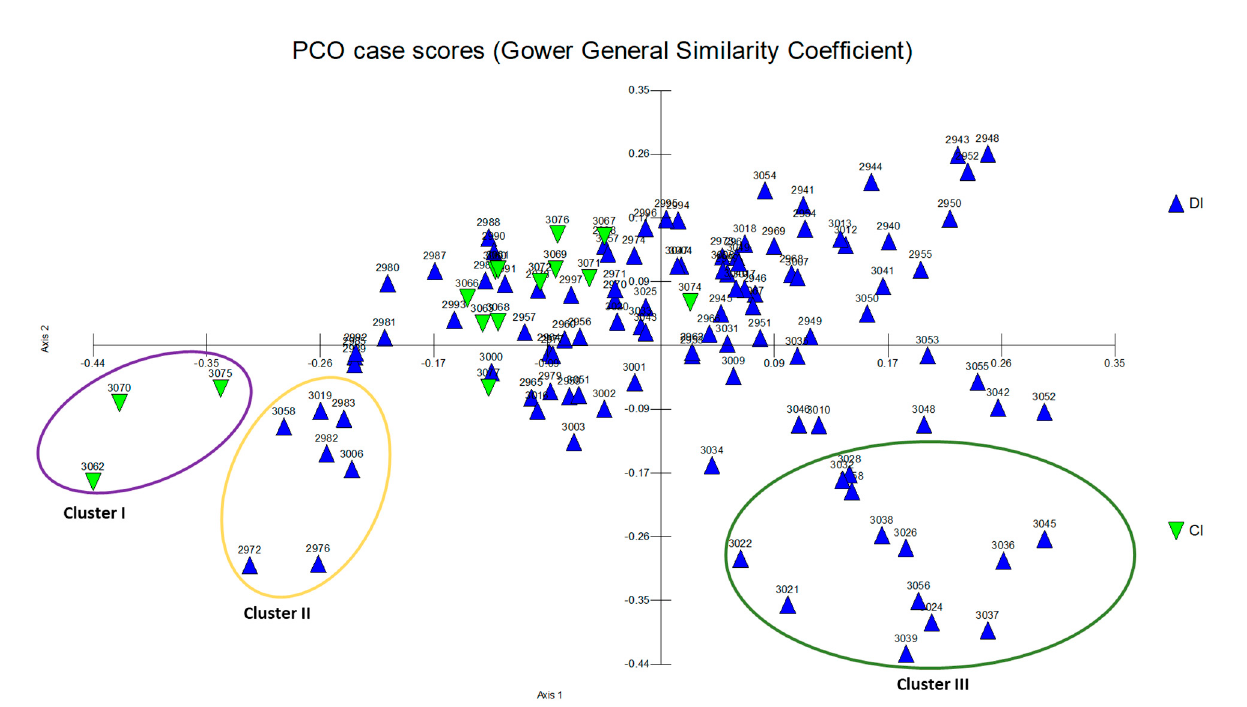
Figure 2. Principal Coordinates Analysis (PCO) scatterplot, showing individuals from the Chão islet and Desembarcadouro islet distributed according to genotypic data.